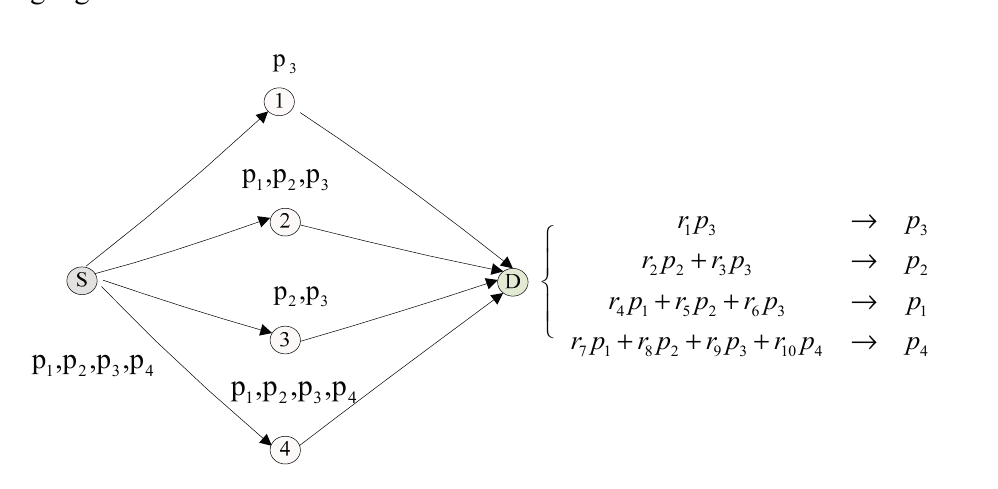
Figure 4. Partial network coding